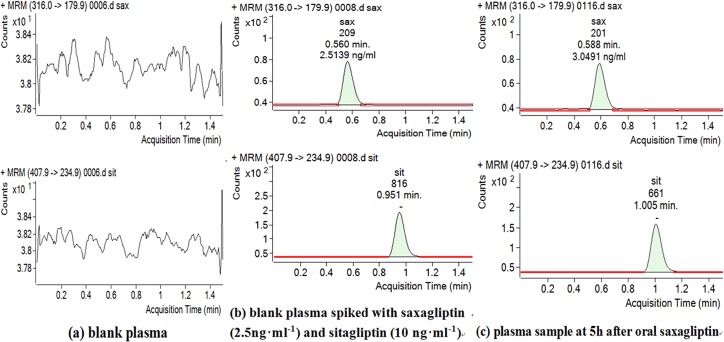
Chromatograms of blank plasma (A), blank plasma spiked with Sax and IS (B) and plasma sample at 5 h after oral Sax (C).